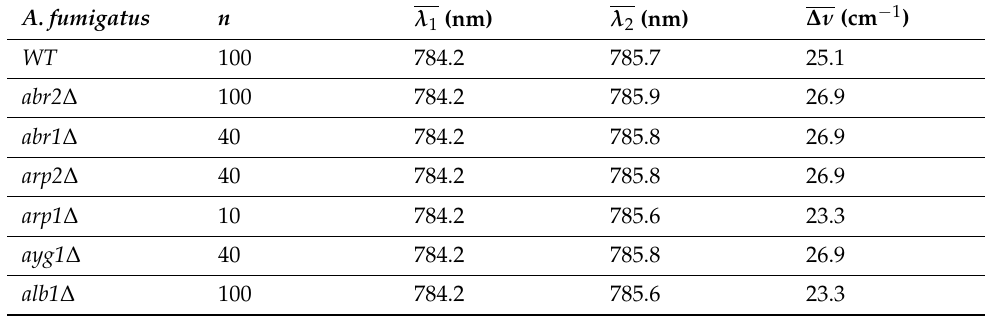
Table 1. Sample and laser parameters for A. fumigatus